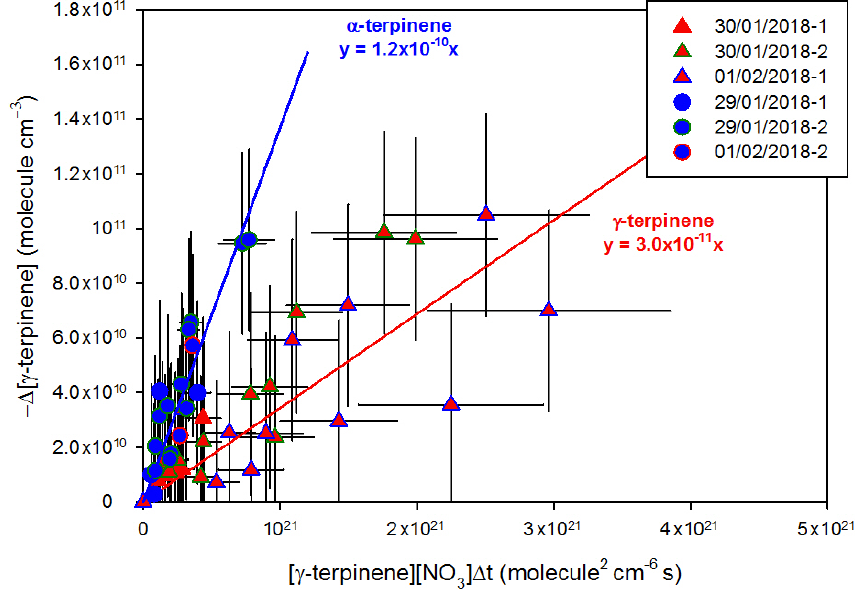
Figure 3. Absolute kinetic plots for γ -terpinene (triangle marks) and for α -terpinene (round marks).